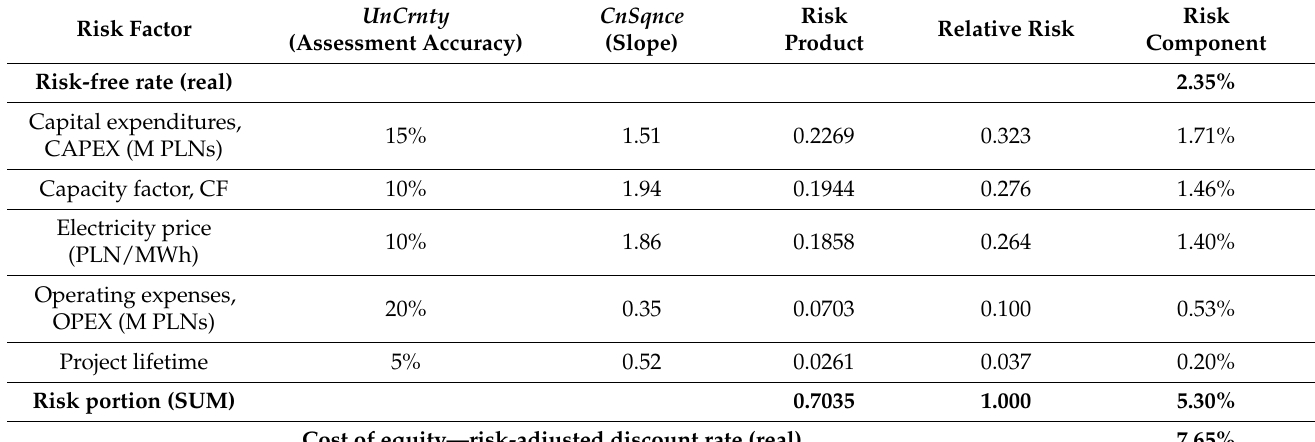
Figure 2. Sensitivity of IRR to key parameters of the typical wind project in Poland. To calculate the CnSqnce values for individual variables, tangents of the slopes of sensitivity curves to the x -axis were calculated. Given the fact that the impact of individual risk factors is aggregate, all tangents of the slope of the sensitivity curves are adopted in the form of absolute values. By multiplying the values of UnCrnty and CnSqnce for every key variable, the value of risk was received and subsequently, by calculating the relative risk, the risk component in the cost of equity—i.e., the CoE/RADR—was received. The results of analysis of risk factors within the scope of the cost of equity are presented in Table 1 and in Figure 3. Table 1. Analysis of risk components within a 7.65% real risk-adjusted discount rate of onshore wind projects in Polish